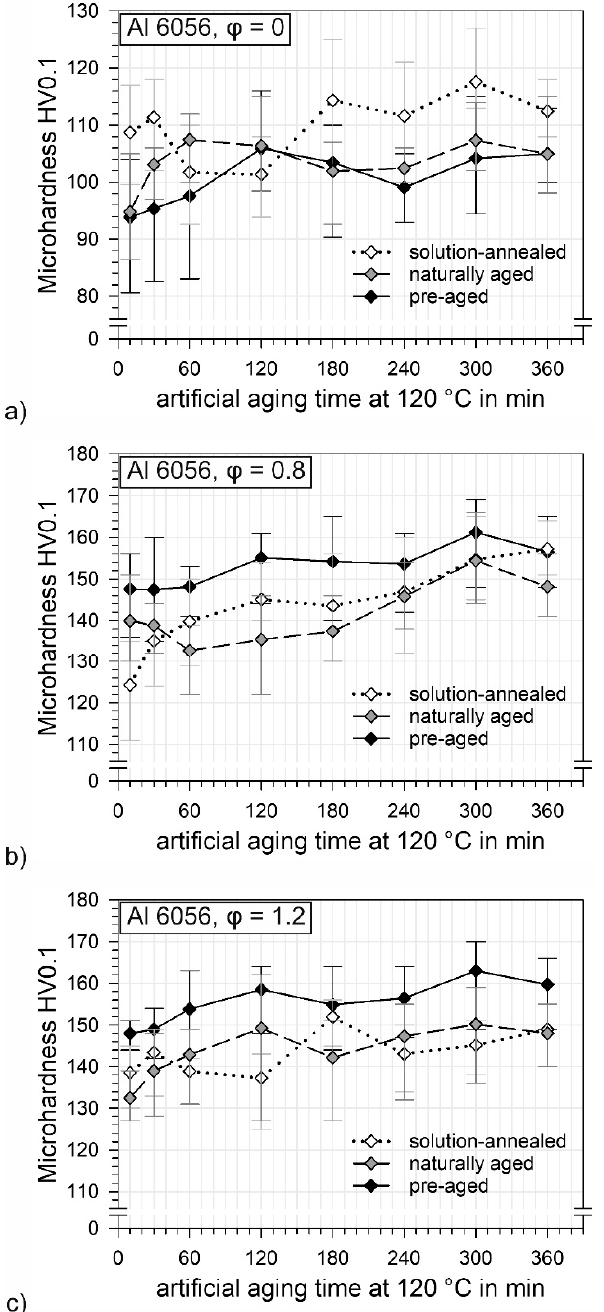
Figure 3. Microhardness of the 6056 aluminum alloy in solution-annealed, pre-aged and naturally- aged conditions as a function of the artificial aging time at 120 °C: ( a ) without previous plastic deformation and ( b , c ) after linear extrusion with induced strains of ( b ) φ = 0.8 and ( c ) φ = 1.2. Depicted are the mean, minimum and maximum values of each microhardness. Plastic deformation and pre-aging increase the hardness during artificial aging.